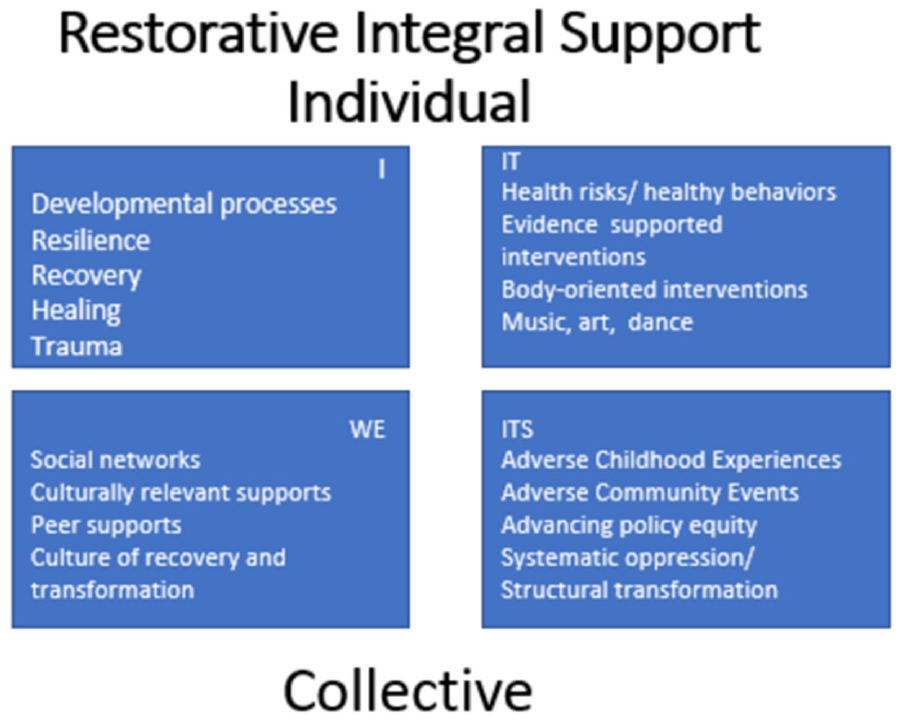
Figure 1. A quadrant perspective on ACEs and